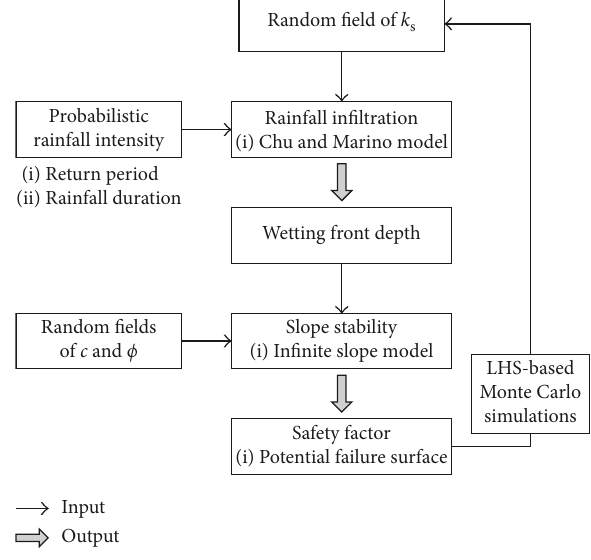
Figure 3: Flow chart for the probabilistic slope